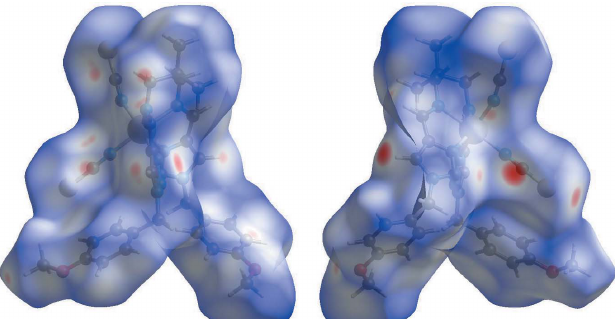
Figure 3 Two projections of d norm mapped on Hirshfeld surfaces, showing the interactions between molecules. Red areas represent regions where contacts are shorter than the sum of the van der Waals radii, blue areas represent regions where contacts are larger than the sum of van der Waals radii, and white areas are regions where contacts are close to the sum of van der Waals